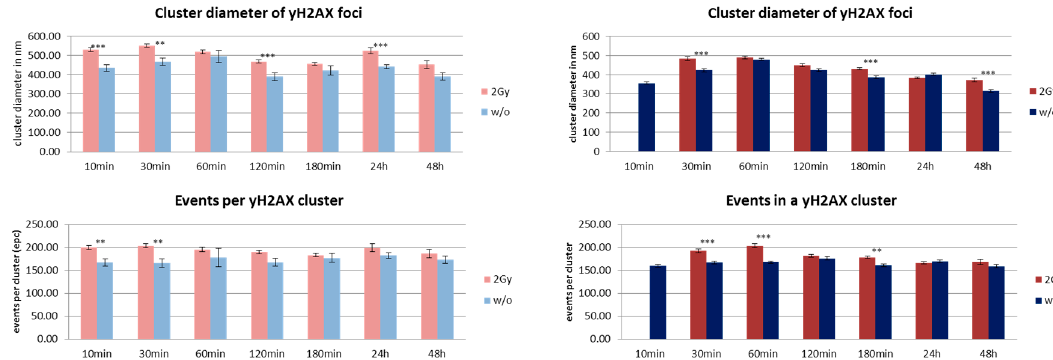
Figure 7. Overview of cluster size results obtained from SMLM measurements. Left panels show the data obtained from MCF-7 breast cancer cell nuclei; right panels show the data obtained from cell nuclei of CCD-1059SK fibroblasts. The columns of each panel represent the mean values calculated from 20 nuclei each. The error bars on top of the column indicate the standard deviation. For each time step after the irradiation process, the data are given for the cells exposed to 2 Gy low LET ionizing radiation (“2 Gy”) and for cells subjected to the same culturing procedure but not to radiation treatment (“w/o”). Level of significance between the corresponding values for “2 Gy” and “w/o”: *** = 0.1%; ** = 1%. For further details see text.